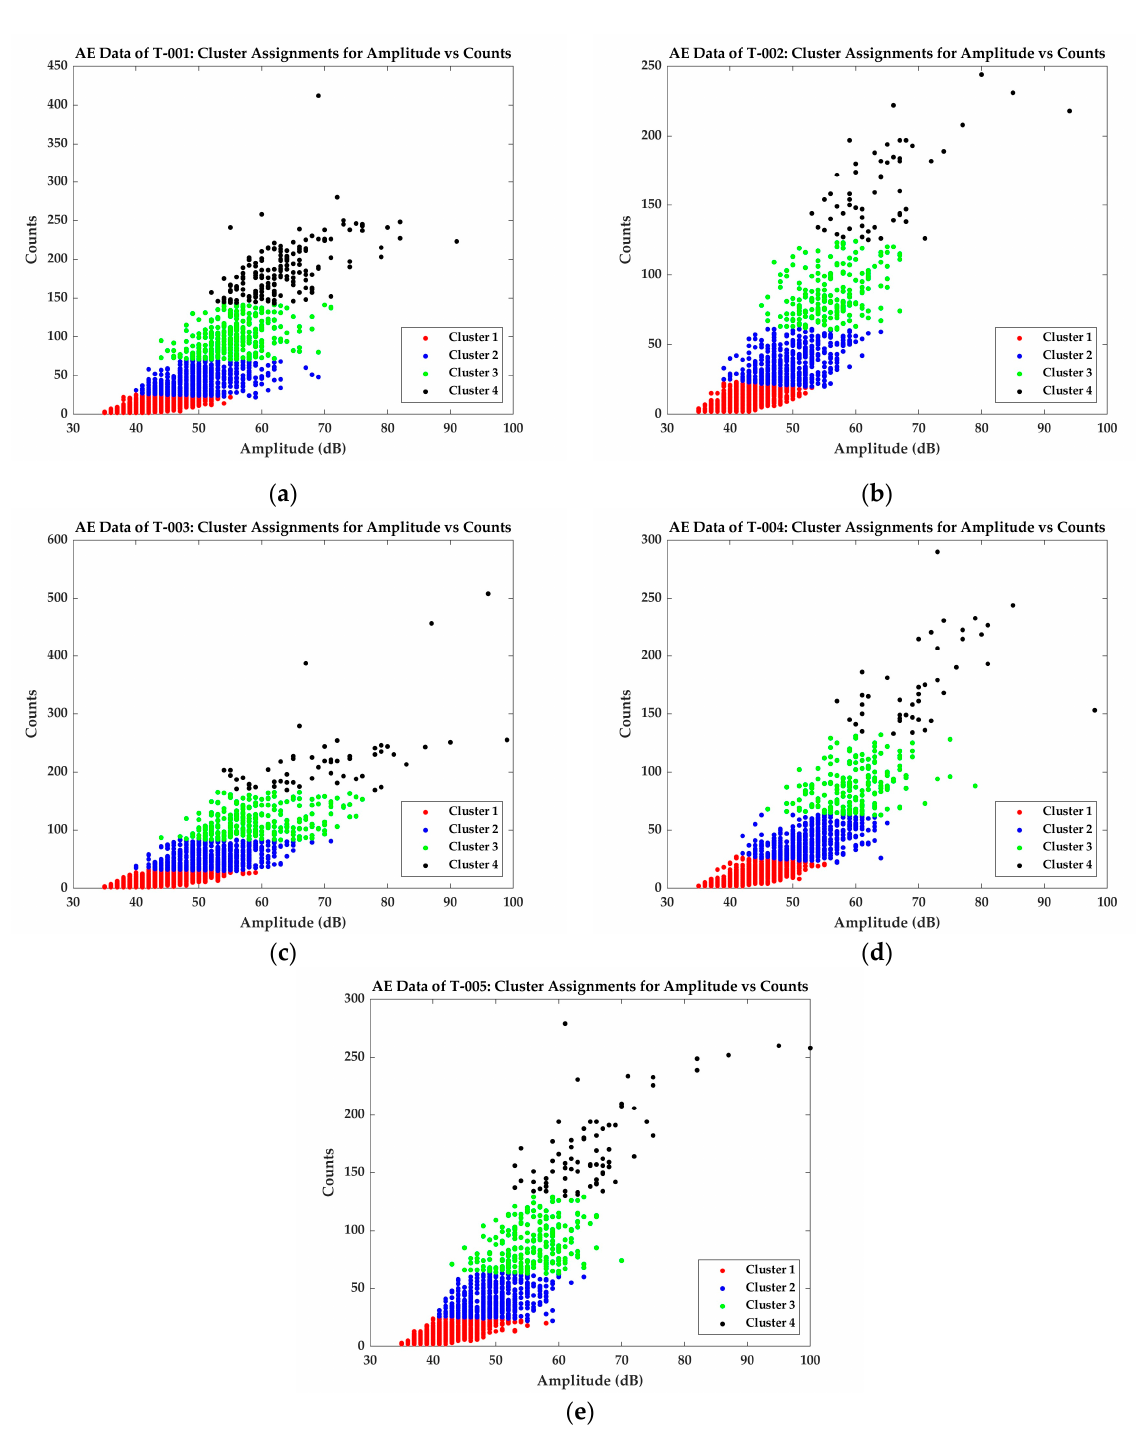
Figure 3. Clustered data based on amplitude and counts of the AE signals recorded from the tensile test of specimens ( a ) T ‐ 001; ( b ) T ‐ 002; ( c ) T ‐ 003; ( d ) T ‐ 004; ( e ) T ‐ 005. The data clustered using k ‐ means++ algorithm show very similar patterns, which shows the good repeatability of AE data acquisition. The similarities in the clustered AE data are summarized in Table 3. Cluster 1 of the AE signals generally have amplitude between 35 dB and 55 dB and counts less than 25. Signals from Cluster 2 have amplitude between 40 dB and 60 dB and counts between 26 and 55. Signals from specimens T ‐ 003 and T ‐ 004 have some signals with amplitude close to 65 dB. Considering the global aver ‐ age of the AE signals in this category, they can be considered as outliers. Signals in Cluster